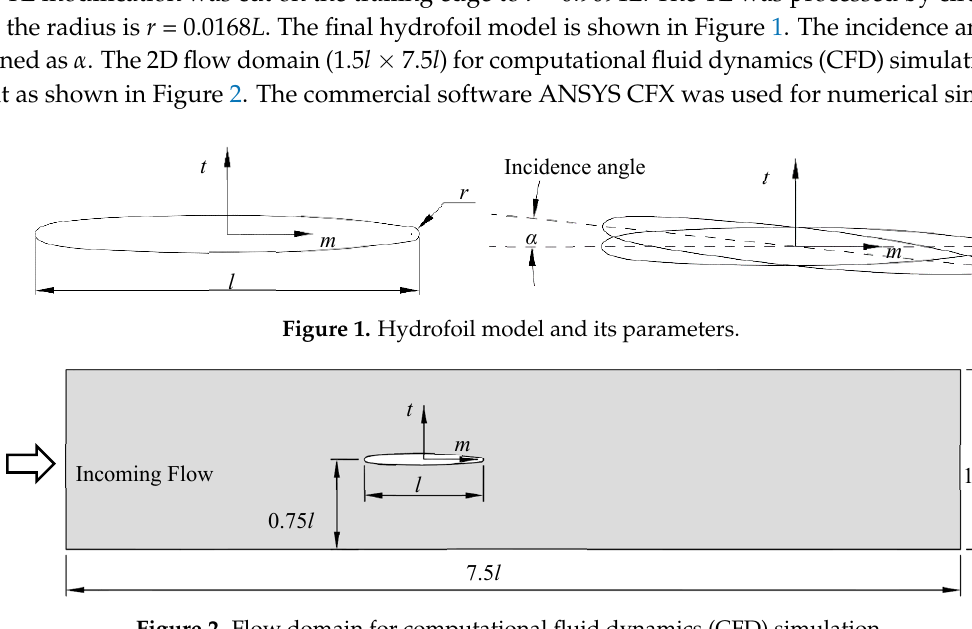
Figure 2. Flow domain for computational fluid dynamics (CFD) simulation.